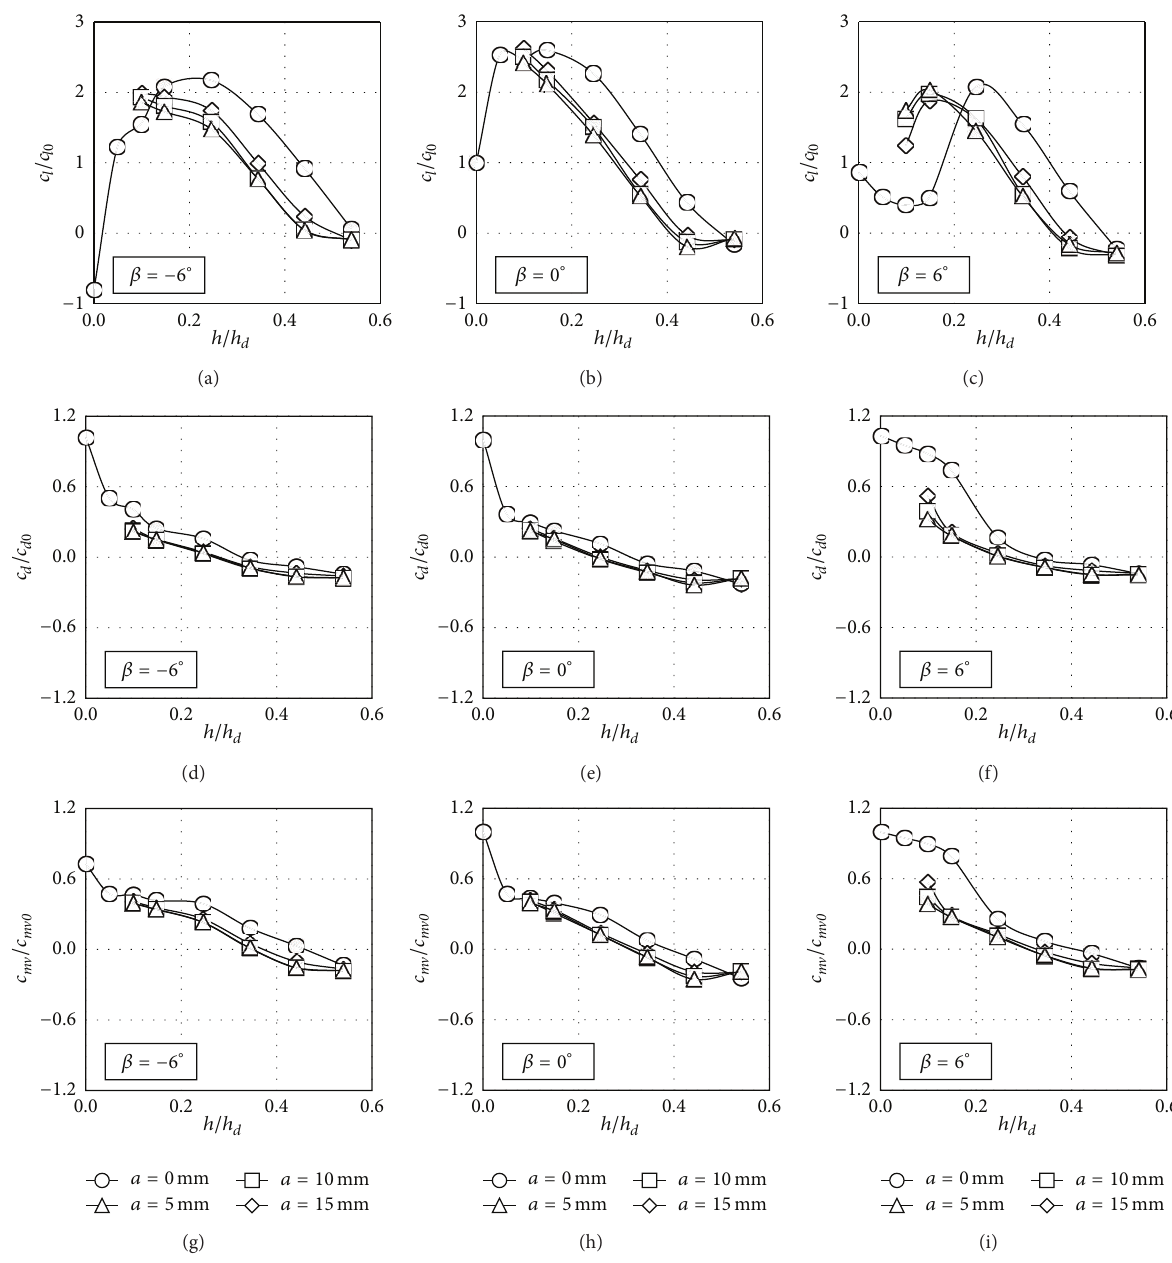
Figure 11: Lift, 𝑐 𝑙 /𝑐 𝑙0 , side force, 𝑐 𝑑 /𝑐 𝑑0 , and rolling moment, 𝑐 𝑚 V /𝑐 𝑚 V 0 , coefficient ratios as a function of the windbreak height, when the train coach is placed on the windward rail on the embankment with slope 1: 2. Four eave lengths are considered, 𝑎 = 0 mm (circles), 𝑎 = 5 mm (rhombi), 𝑎 = 10 mm (squares), and 𝑎 = 15 mm (triangles). Each column represents a different coach rolling angle, 𝛽 = −6 ∘ (left), 𝛽 = 0 ∘ (centre), and 𝛽 = 6 ∘